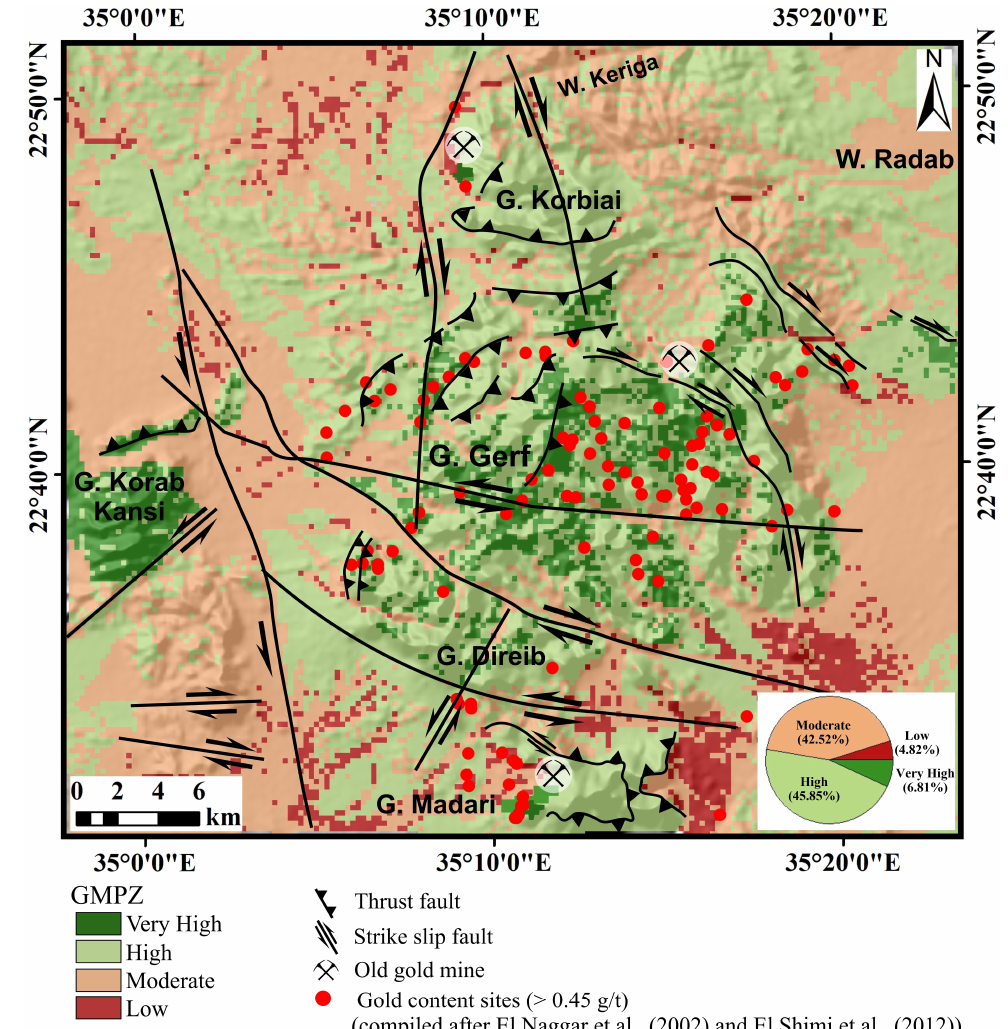
Figure 18. The Gold mineralization potential zones map, (inset circle shows the percentage of each potential zones. The gold content sites are complied after